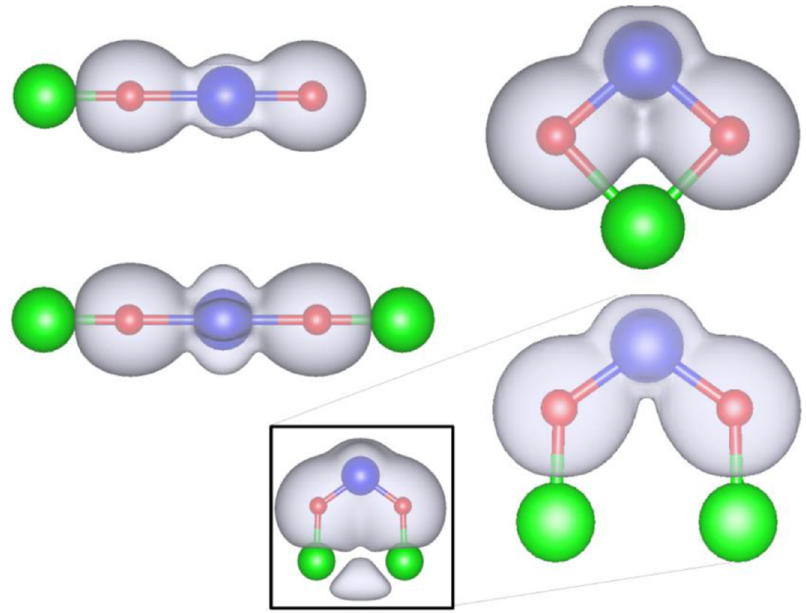
Figure 5. Geometries of four optimized lithiated TiO 2 molecules. From top left to bottom right: LiTiO 2 (linear), LiTiO 2 (bent), Li 2 TiO 2 (linear), Li 2 TiO 2 (bent). Isosurface plots of the charge densities in every molecule (isosurface value: − 0.03 a.u.) are shown in grey. Ti atoms are represented as blue, oxygen as red, and lithium as green colored spheres. The inset shows an isosurface plot with a lower isovalue ( − 0.006 a.u.) for bent Li 2 TiO 2 in order to visualize the non-nuclear attractor (bond) between the two Li ions. Reproduced from Ref. [22], used in accordance with the Creative Commons Attribution (CC BY 3.0) license (https://creativecommons.org/licenses/by/3.0/, accessed on 20 August